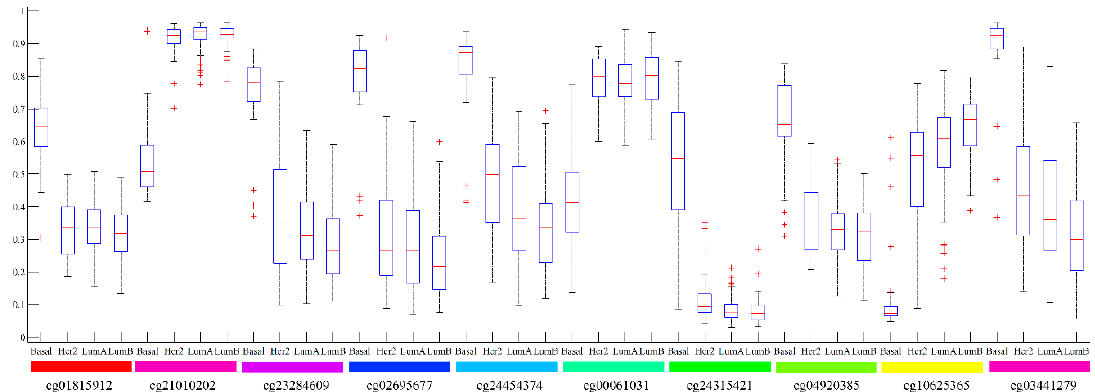
Figure 5. Boxplots to illustrate the distributions of top ten features on four breast cancer subtypes.